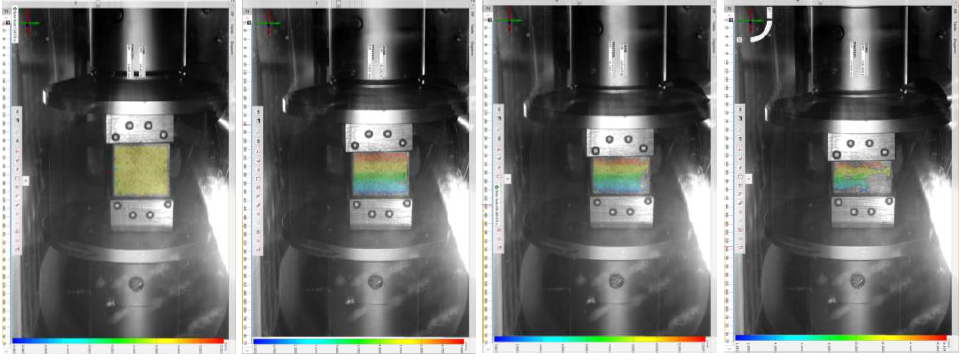
Fig. 2. Visualization of the compression test of sample 75-2. From left to right after 54 s, 272 s, 465 s and 563